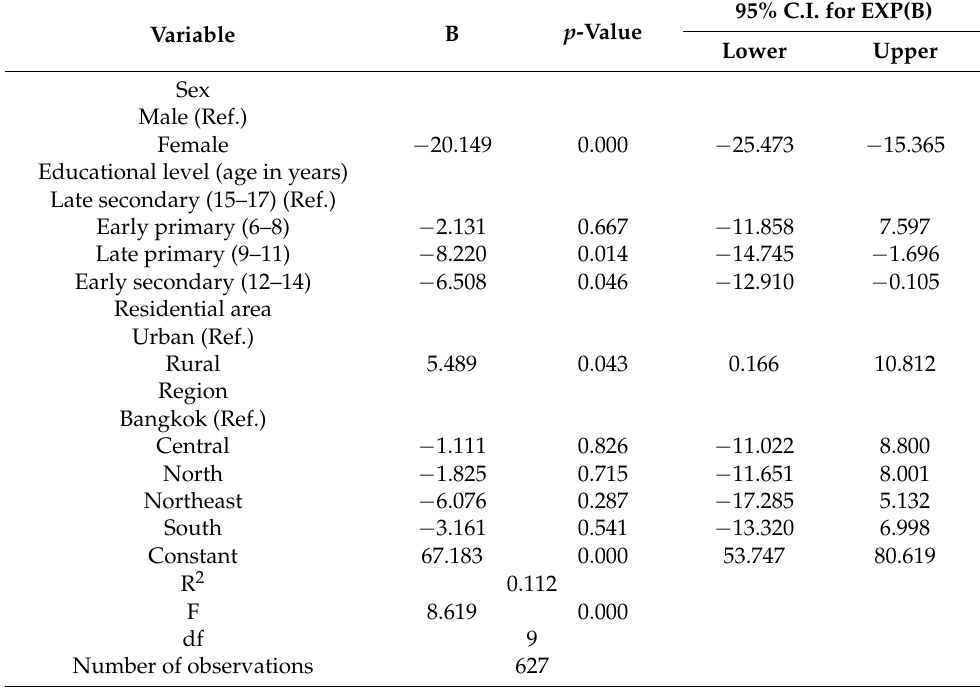
Table 5. Determinants of change in average daily MVPA among Thai children and young people